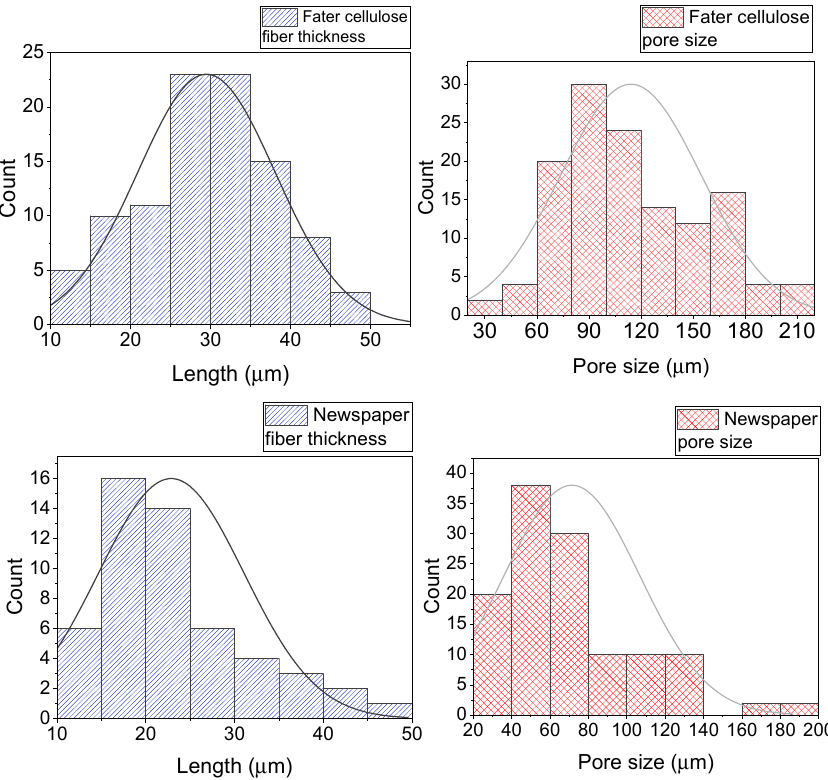
Figure 3. Pore size and fiber thickness distribution of the diaper cellulose and newspapers determined by LCSM analyses (at least 100 measurements).